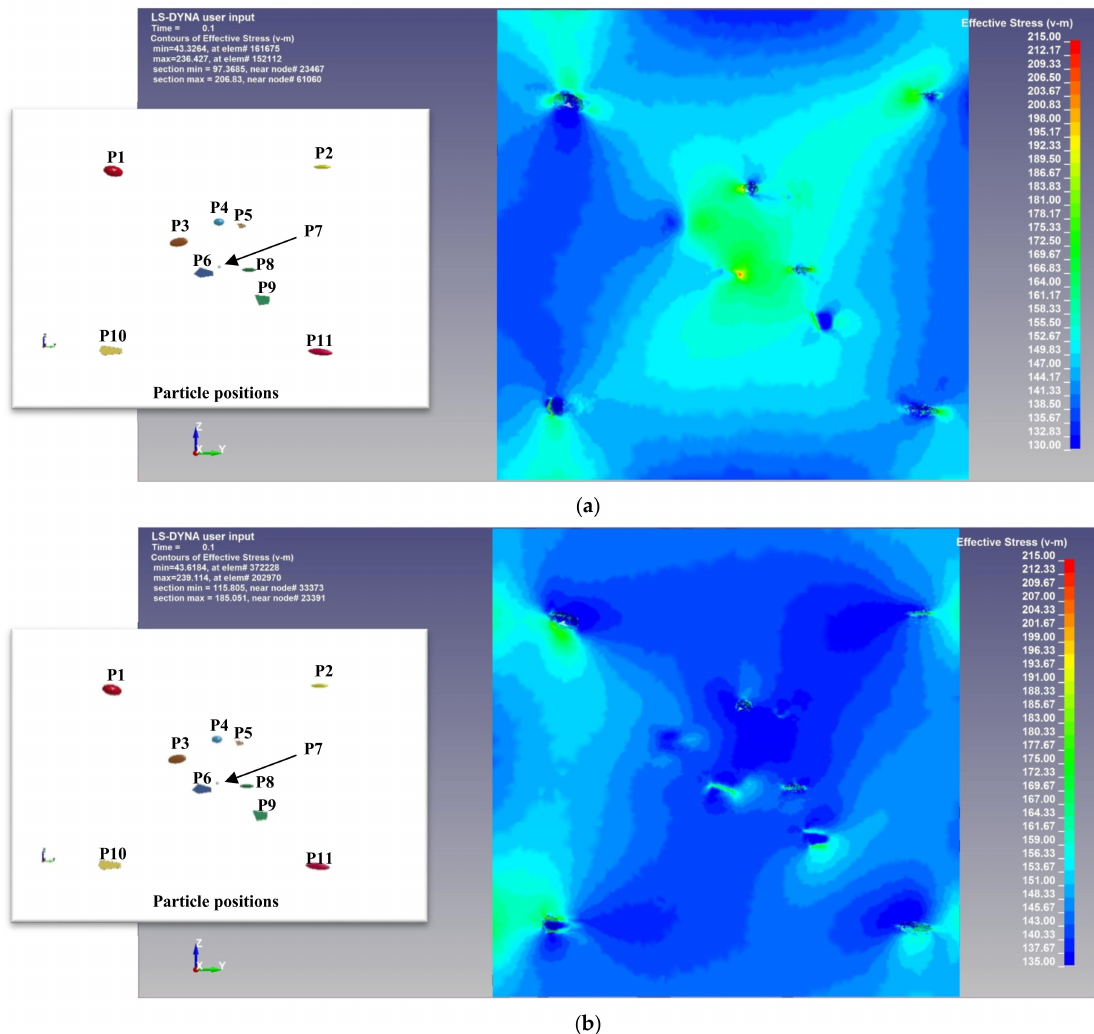
Figure 16. Mid-thickness cross-section Von Mises stress fields (units in MPa): ( a ) Load aligned with extrusion direction and ( b ) load transverse to extrusion direction. The particle positions are given as